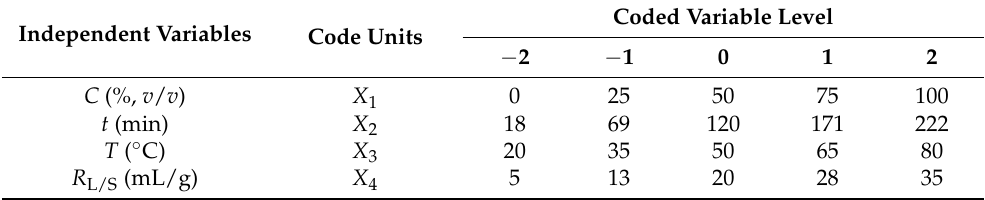
Table 1. The actual and coded levels of the independent variables were used to optimize the process. Independent